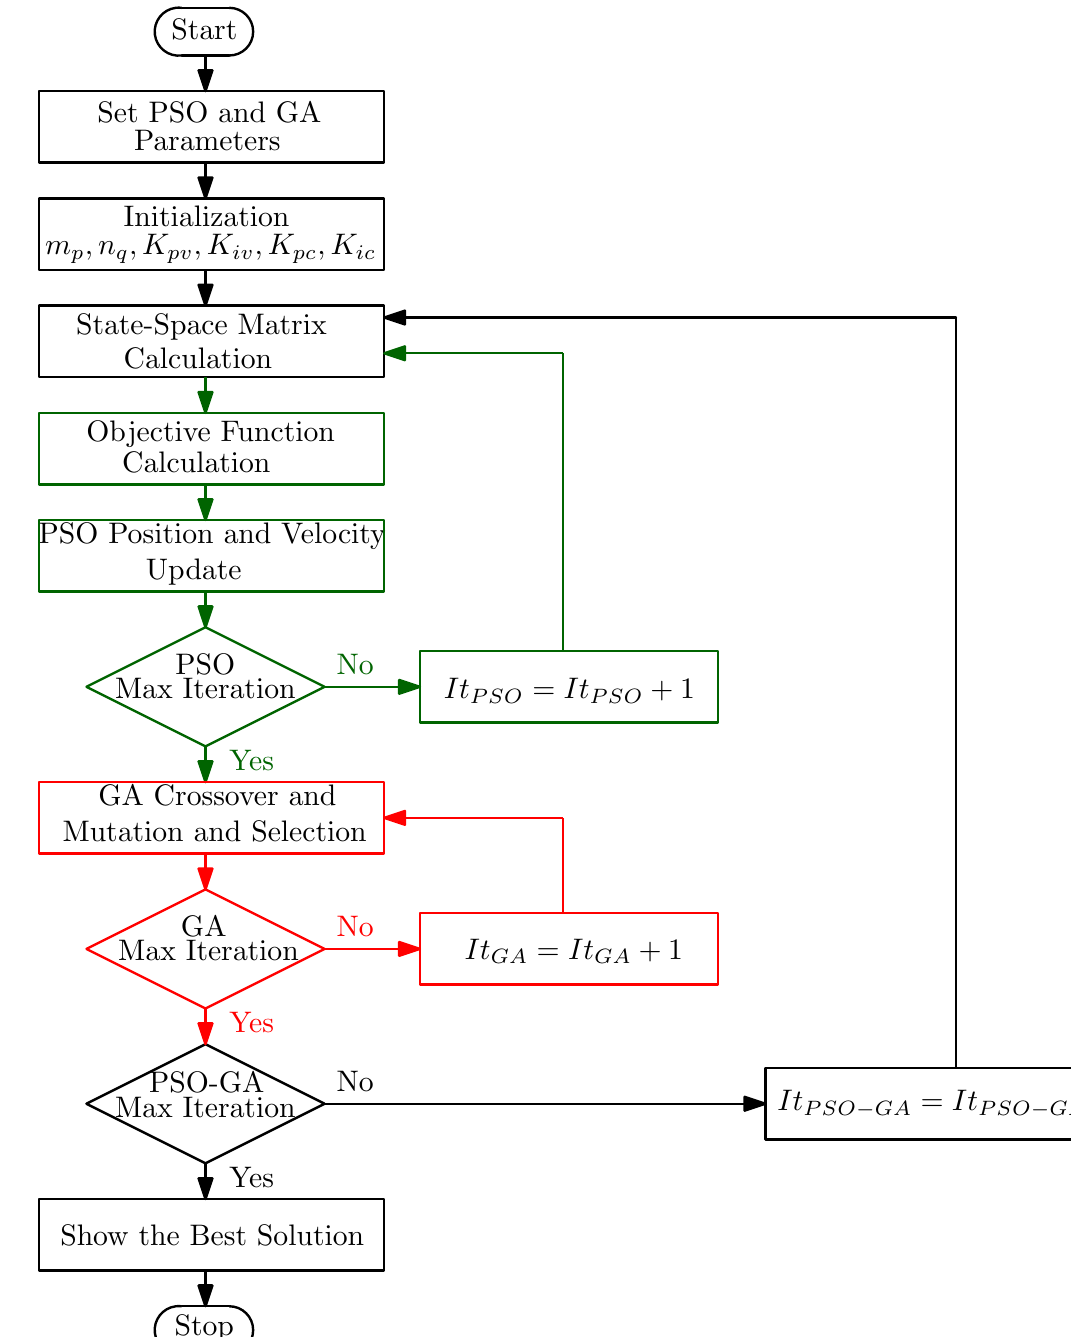
Figure 6. The proposed PSO-GA algorithm